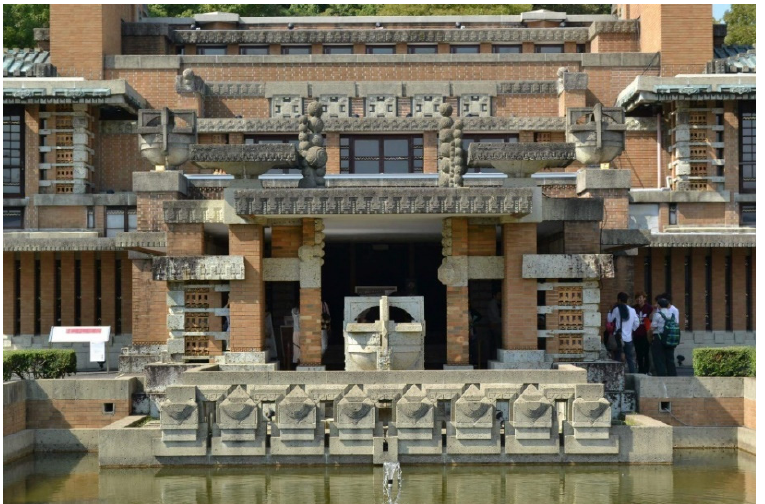
Figure 1. Imperial Hotel reconstruction at Inuyama (Gifu) showing masonry, abundant ornamenta- tion, and open disregard for local conditions and climate. 1.—In grey: decorations in stone, resembling Mayan claddings. Stone is a very unusual material in façades in Japan, inadequate for resisting seismic forces, and it was nowhere to be found near Tokyo. 2.—In clay color: artistic brickwork, which had already proven a failure when subject to earthquakes and other stresses. Source: authors.